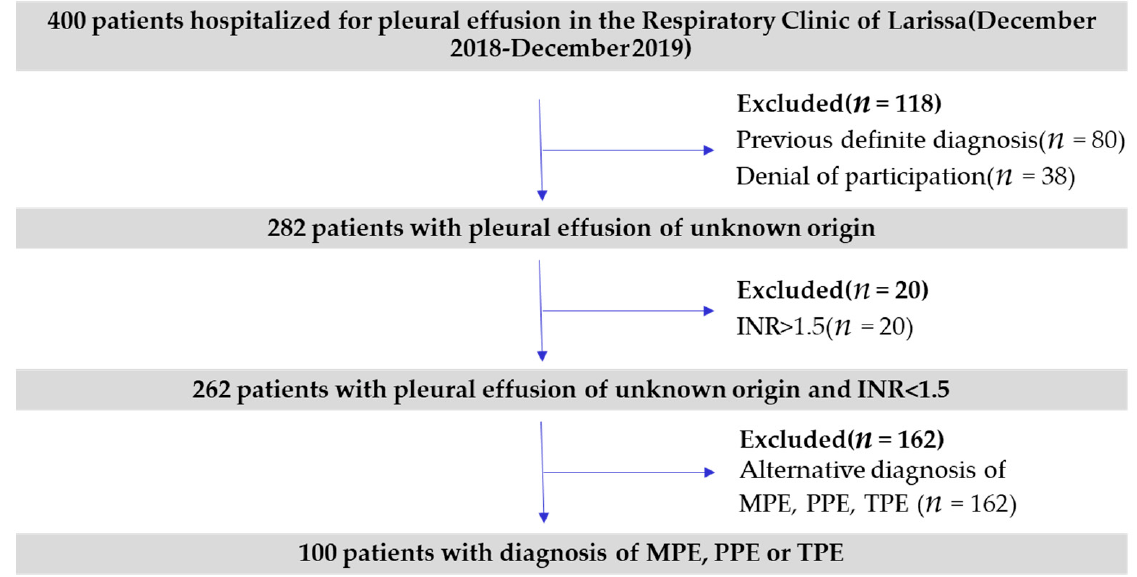
Figure 1. Flowchart of patients participating in the study. INR = international normalized ratio, MPE: malignant pleural effusion, PPE = parapneumonic pleural effusion, TPE: tuberculous pleural effusion.